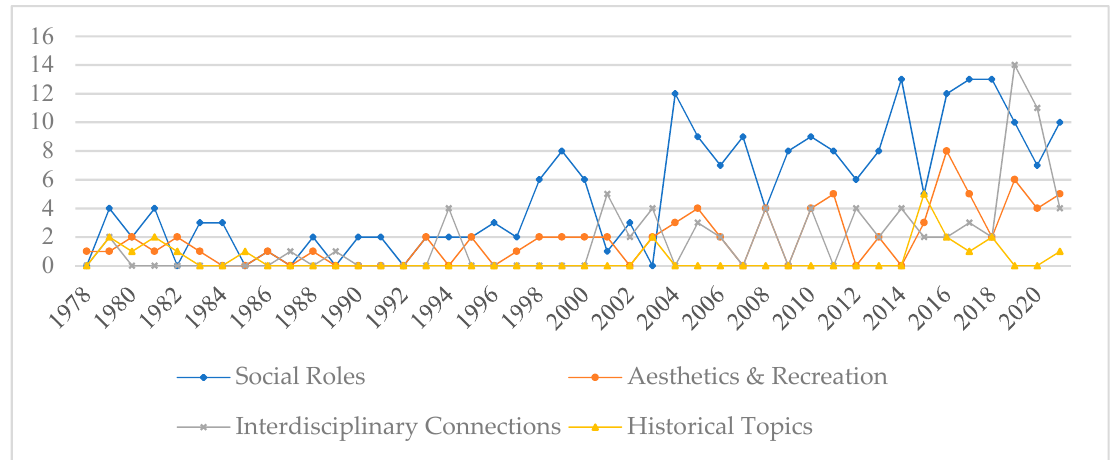
Figure 4. Line graph of the changes in the number of test items with mathematical culture in different categories.